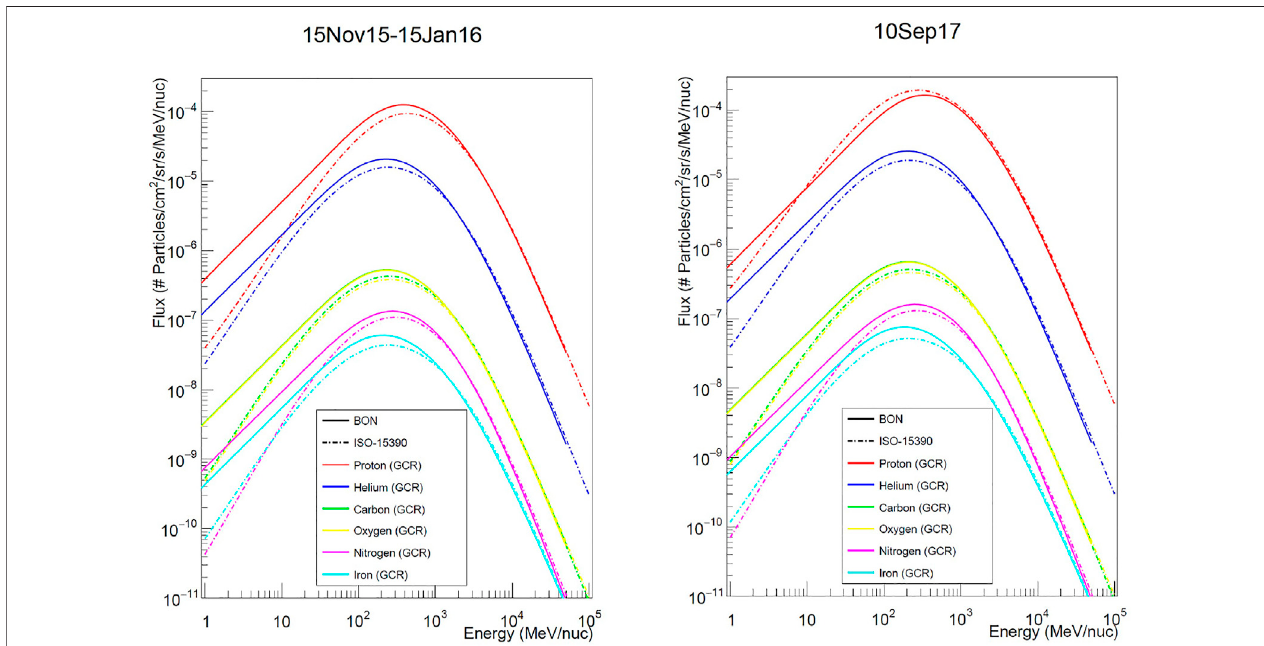
FIGURE 1 | Primary simulated spectra for GCR hydrogen (Z = 1), helium (Z = 2), carbon (Z = 6), nitrogen (Z = 7), oxygen (Z = 8) and iron (Z = 26) for 15 November 2015 – 15 January 2016 (left) and 10 September 2017 (right) based on the ISO-15390 (dot-dashed lines) and BON 2014 (full lines) GCR models.